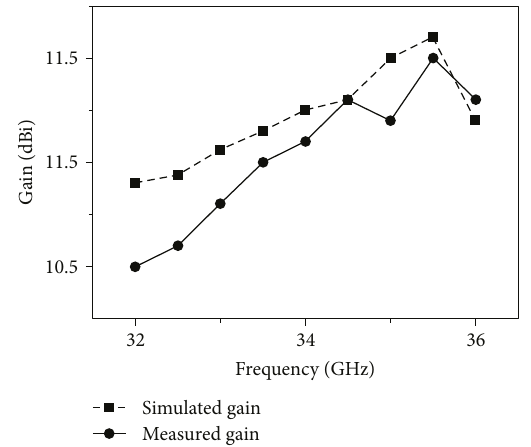
Figure 8: Simulated and measured gains of the proposed